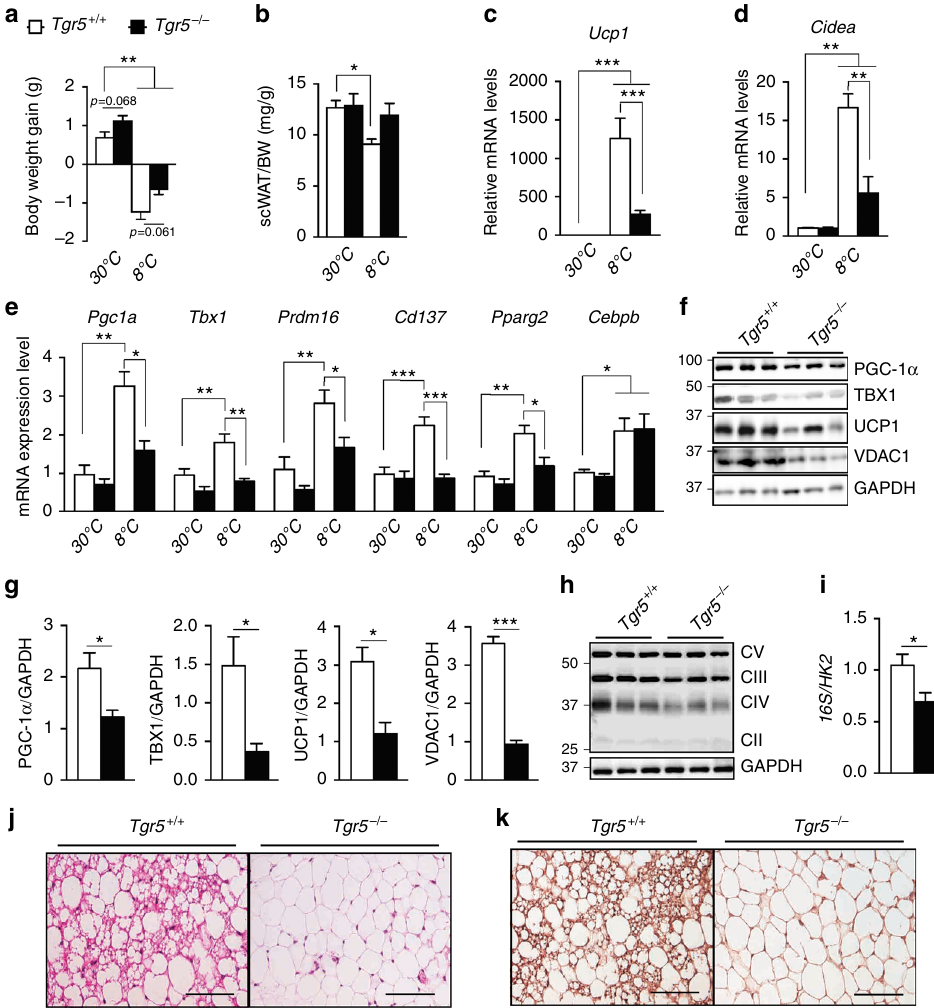
Fig. 1 TGR5 is required for cold-induced scWAT beiging. a Body weight gain of TGR5 wild-type ( Tgr5 + / + ) and germline TGR5 knockout ( Tgr5 − / − ) mice housed at thermoneutrality (30 °C) or exposed to cold (8 °C) for 7 days. n = 10 per group. b scWAT over body weight (BW) ratio of mice described in a . c – e mRNA levels of beige remodelling markers Ucp1 ( c ), Cidea ( d ), Pgc1a , Tbx1 , Prdm16 , Cd137 , Pparg2 and Cebpb ( e ) in the scWAT of mice described in a . f Representative ( n = 10 per group) western blot of PGC-1 α , the mitochondrial marker VDAC1 and beiging markers TBX1 and UCP1 from the scWAT of cold- exposed mice described in a . GAPDH was used as loading control. g Quantitative densitometry of the western blots showed in f . h Representative ( n = 10 per group) western blot of mitochondrial OXPHOS complexes (CII – CV) from the scWAT of cold-exposed mice described in a , GAPDH was used as loading control. i Quanti fi cation of mitochondrial (16S) vs. nuclear (HK2) DNA ratio from the scWAT of cold-exposed mice described in a . j , k Representative haematoxylin and eosin ( j ) and UCP1 ( k ) stainings of scWAT sections from cold-exposed mice described in a . Scale bars = 50 μ m. Results represent mean ± SEM. * P ≤ 0.05, ** P ≤ 0.01 and *** P ≤ 0.001 vs. Tgr5 + / + group (at 30 and/or 8 °C) by one-way ANOVA followed by Bonferroni post hoc test ( a – e ) or Student ’ s t -test ( g , i ). Uncropped western blots are provided in Supplementary Fig. 9A –